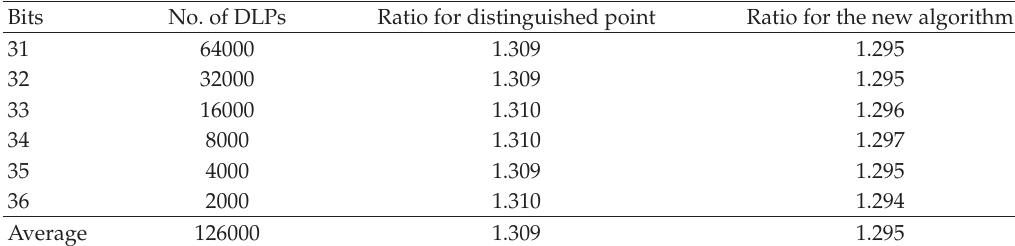
Table 2: Di ff erent performance for distinguished point method and the new